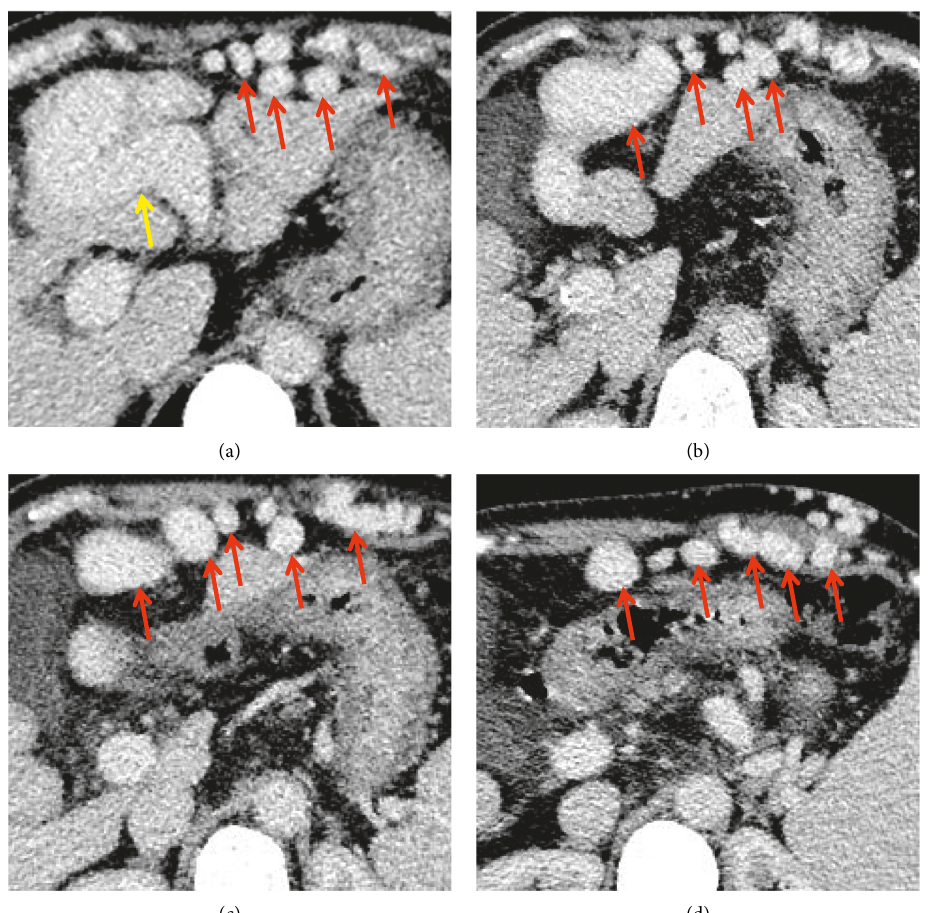
Figure 7: Recanalized paraumbilical vein. In a 65-year-old female with liver cirrhosis, the axial contrast-enhanced CTscan on the portal vein phase demonstrated that the recanalized paraumbilical vein (red arrow) was a round, dilated, or tubular enhanced structure, originating from the left portal vein branch (yellow